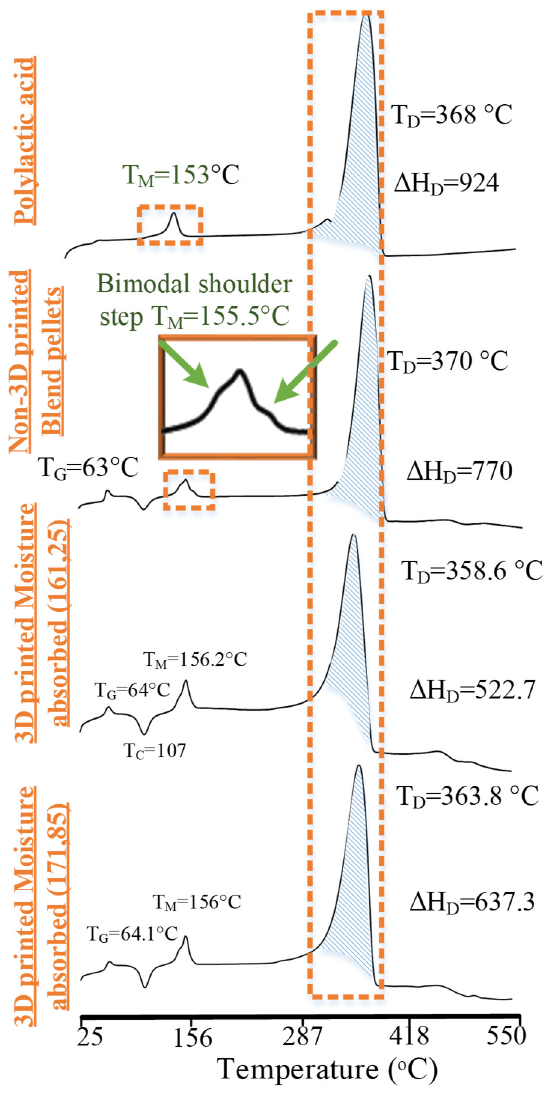
Figure 9. DSC analysis for the non-printed pellets and the 3D-printed blend. Both non-printed and printed blends presented visible signs of excessive physical interlocking of PP in PLA (Figure 10). All thermographs showed a second step of PP at temperatures greater than 400 ◦ C. As PP is 7.5% in the blend, the second step occurred at about less than 7.5% in both non-printed and printed blends. The occurrence of the second step at less than the added composition of PP confirms the limited chemical grafting and excessive physical interlocking [13]. The chemical grafting was probably formed between CH 3 groups of PLA and C-H and C=O groups of MAH, as noted in FTIR analysis (Figure 8) [13]. The physical interlocking was confirmed by the bimodal melt crystallization peak in DSC analysis for non-printed and printed blends (Figure